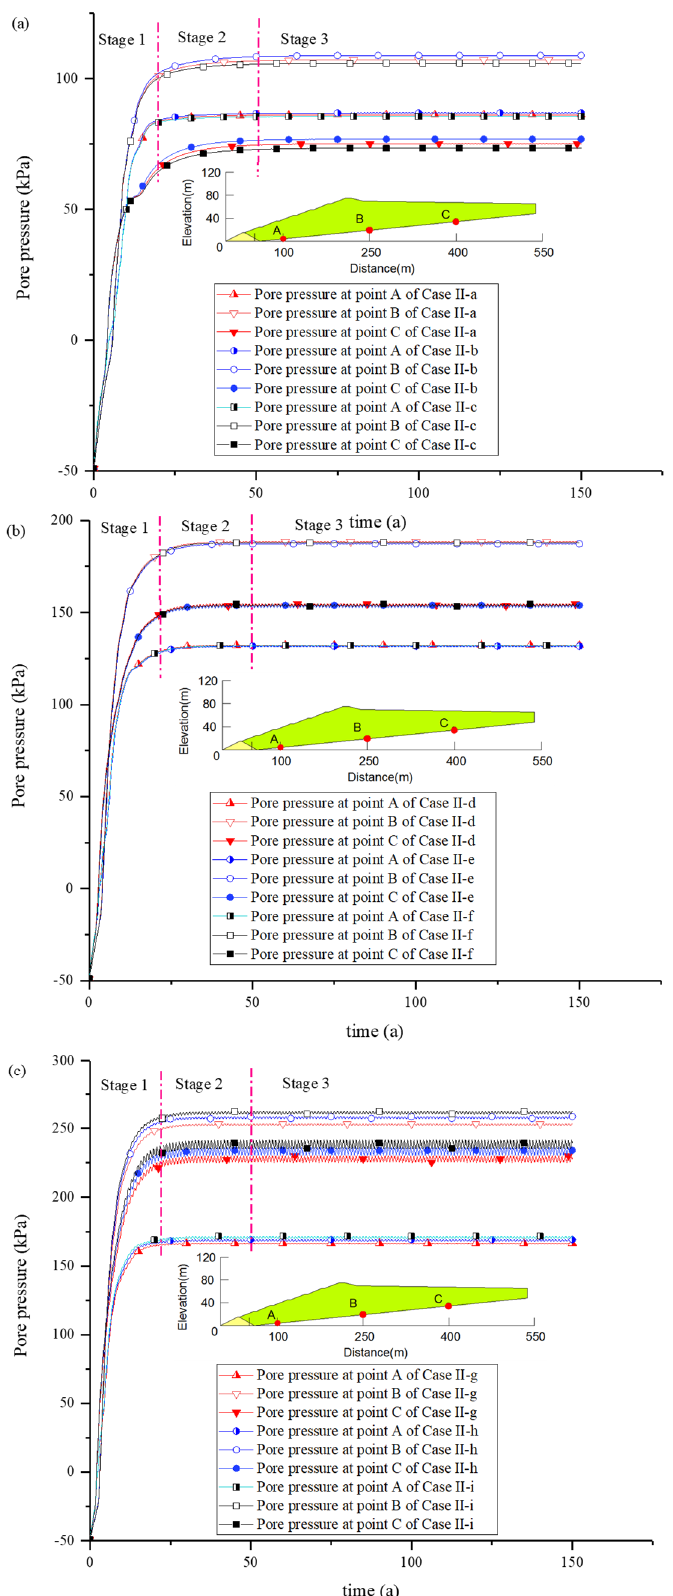
Figure 5. Pore pressure curves of the seepage field in a dry-stack tailings pond under different rainfall patterns: ( a ) Taiyuan: 2018, 2019, and 2020; ( b ) Zhengzhou: 2018, 2019, and 2020; ( c ) Guiyang: 2018, 2019, and 2020.